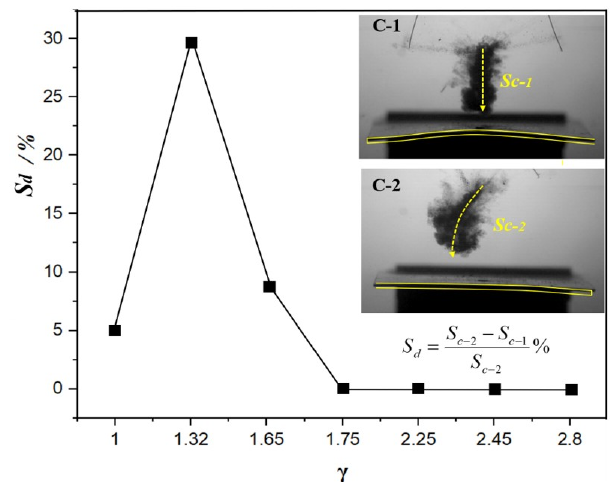
Figure 13. Bubble migration distance ratio near C-1 and C-2 plates.